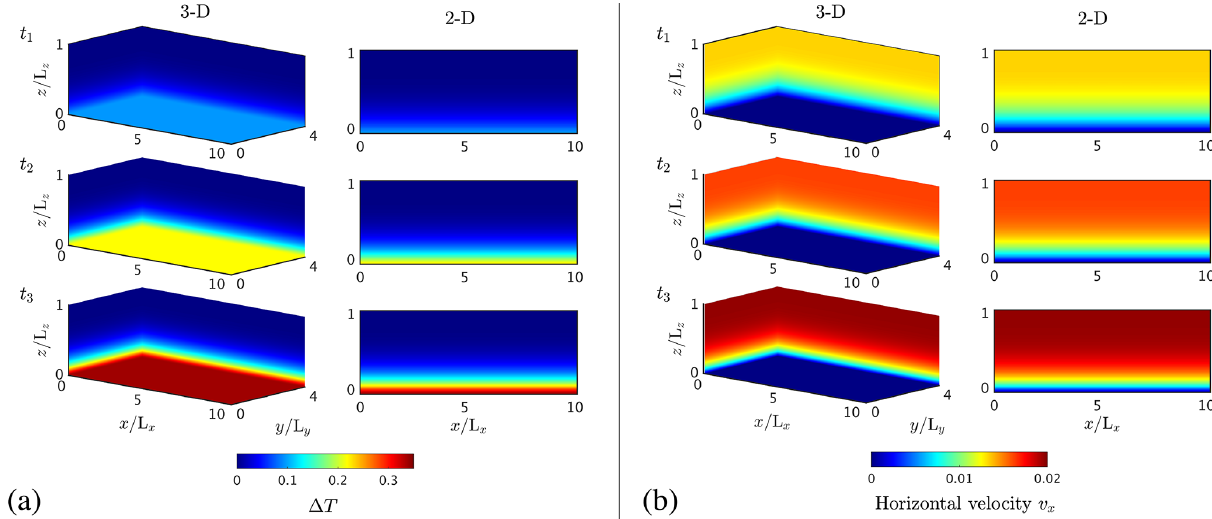
Figure 9. Spatial distribution of (a) the temperature deviation from the initial temperature T and (b) the horizontal velocity component v x for 3-D (a) and 2-D (b) in non-dimensional units. We scale the domain extent with L z . We compare the numerical solutions at non-dimensional times 0 . 7 × 10 8 , 1 . 4 × 10 8 and 1 . 9 × 10 8 .